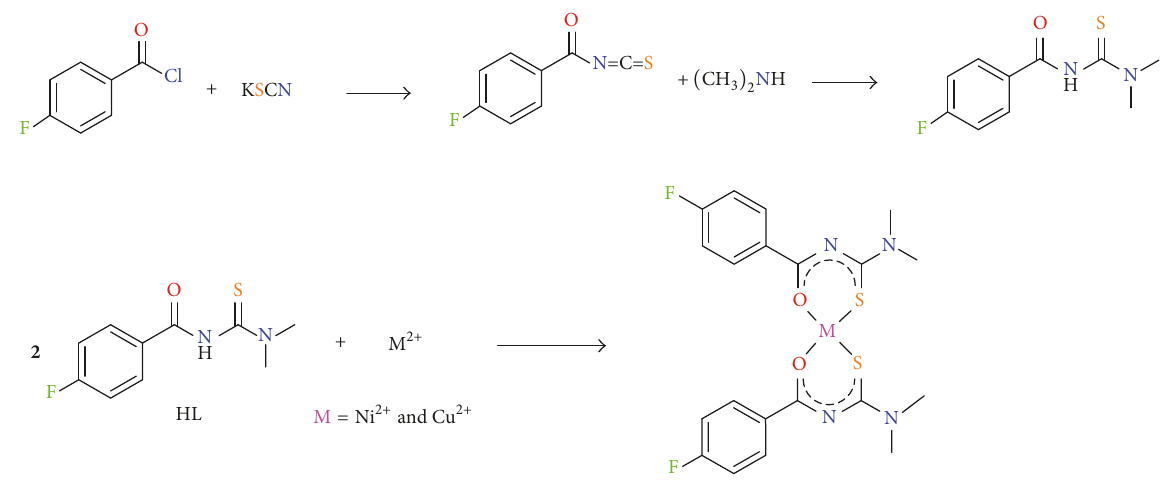
Scheme 1: Synthesis reaction of the ligand and metal